Question: How would you classify this visualization?
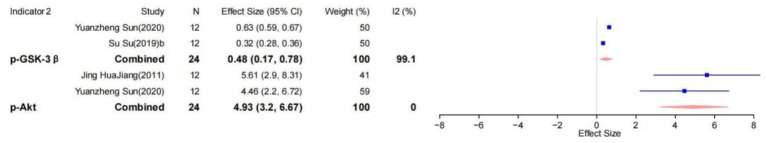
Answer: forest